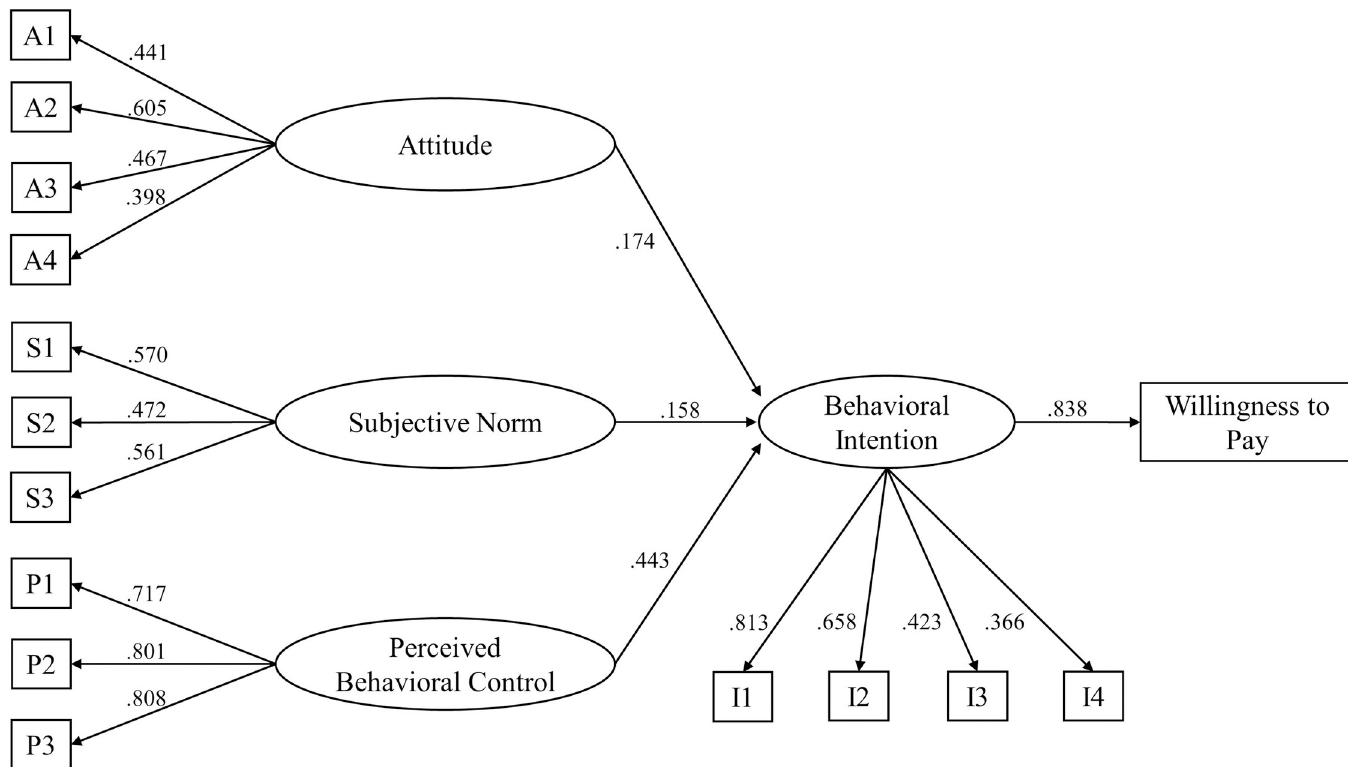
Fig 2. Factors influencing willingness to pay according to the structural equation